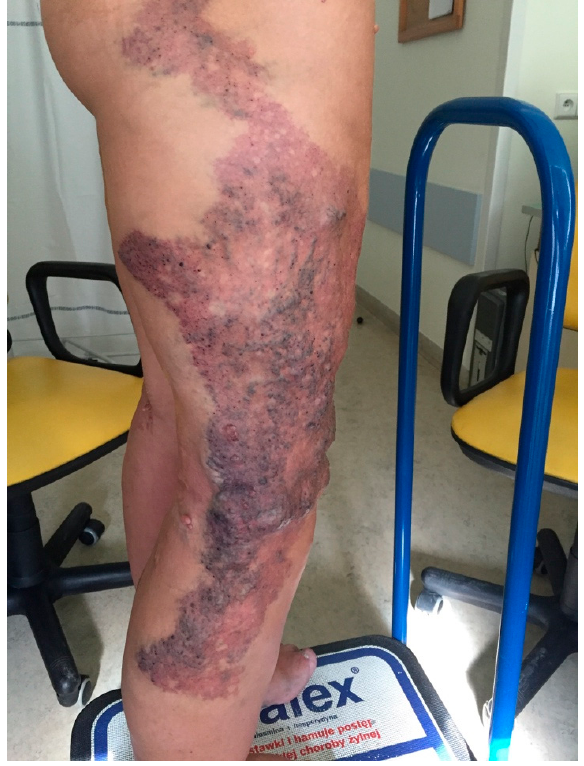
Figure 3. Clinical presentation pre-ablation with Flebogrif.